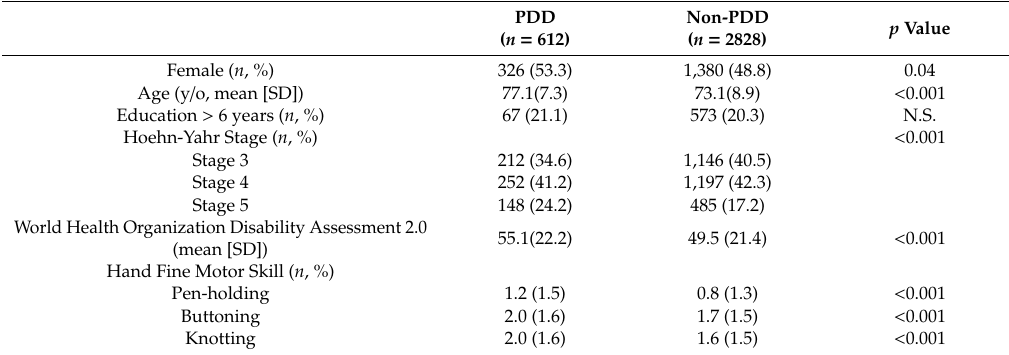
Table 1. Patient demographic data.